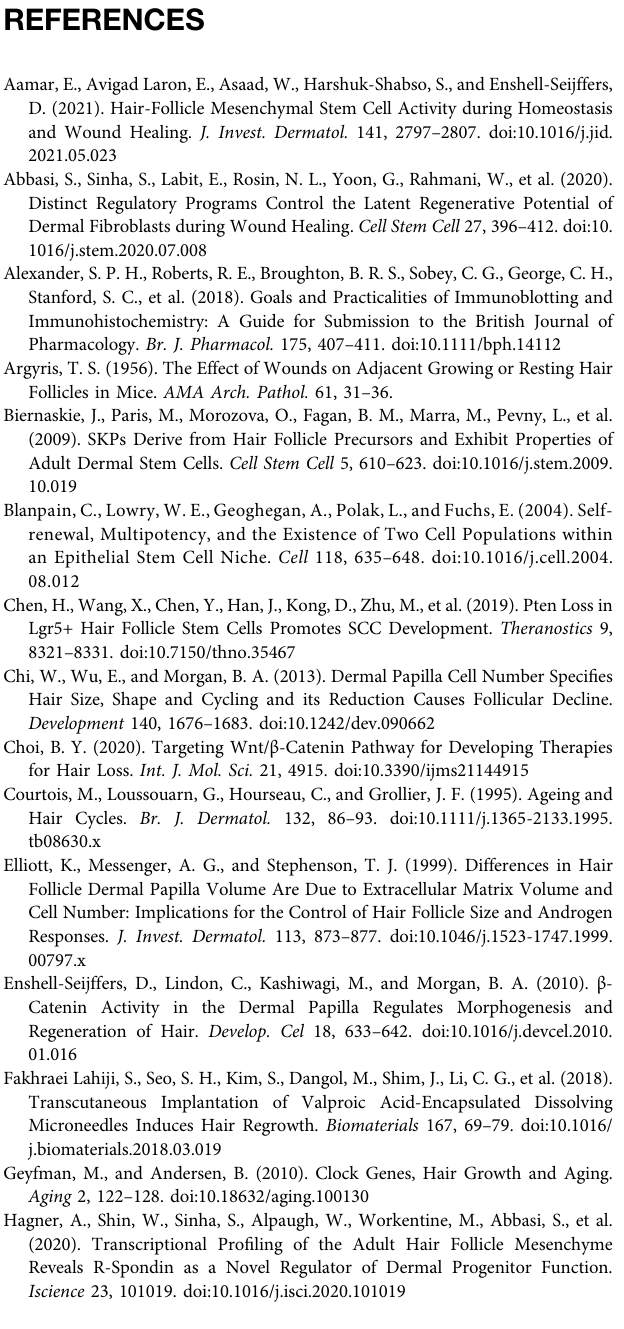
Supplementary Figure 7 | CD34 + mesenchymal cells give rise to DP and DS cells upon transplantation. (A,B) Skin tissues from CD34:mTmG (A) and CD34:mTmG: β - cat act (B) mice1 daypostinjection.Dottedlinesrepresentadiposelayer. (C,D) Skinslices from CD34:mTmG (C) and CD34:mTmG: β -cat act (D) mice 7 days postinjection. (E,F) Dorsal skin sections of CD34:mTmG (E) and CD34:mTmG: β -cat act (F) mice 20 days postinjection. Arrowhead indicates mGFP-labeled DP. Scale bars, 50 μ m. Supplementary Figure 8 | K15: β -cat act mice did not show aging phenotype. (A) Representative pictures of K15: β -cat act mice and control β -cat act littermates at 25 days post depilation. There was no noticeable thinning of hair in K15: β -cat act mice. (B,C) Representative HE images of skin sections from K15: β -cat act and β - cat act mice at 10 days post depilation. (D,E) Representative HE images of skin